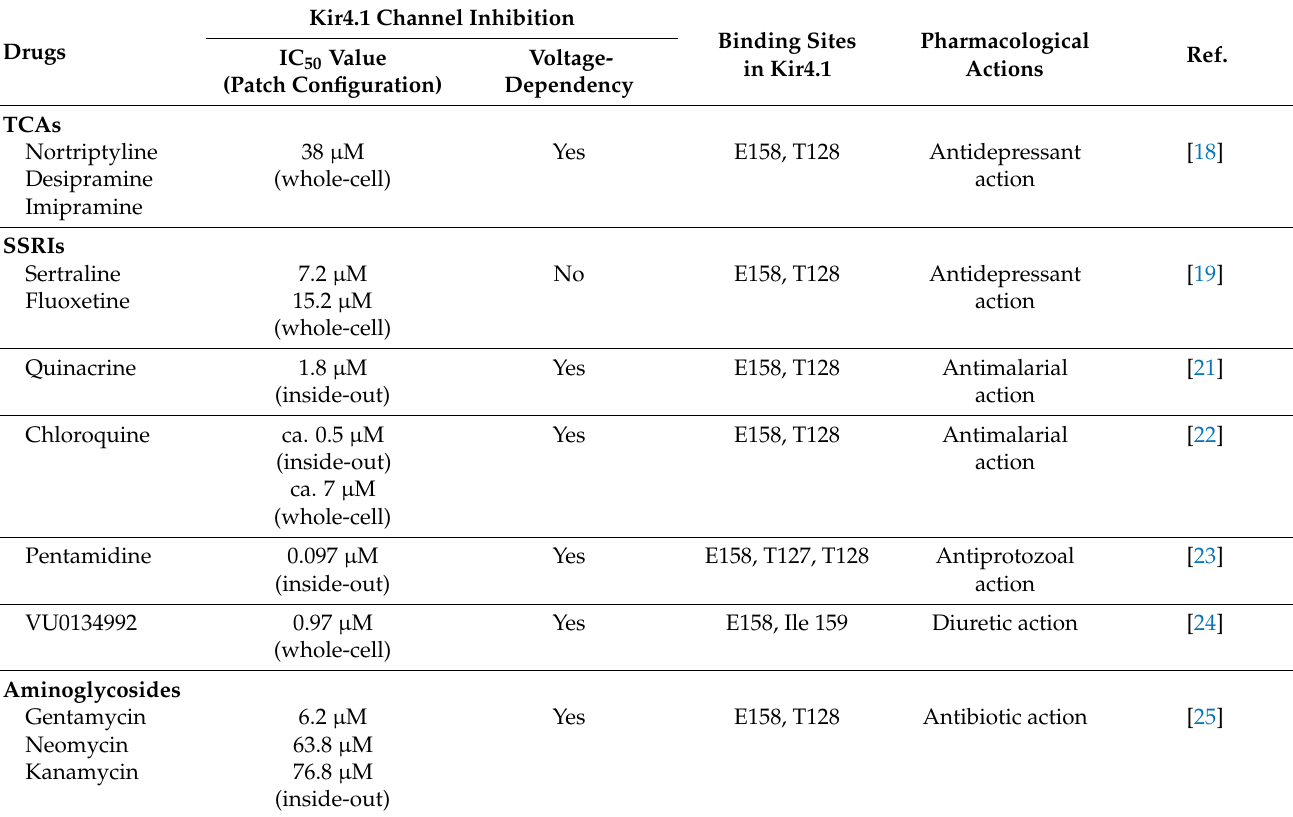
Table 1. Pharmacological properties of Kir4.1 channel